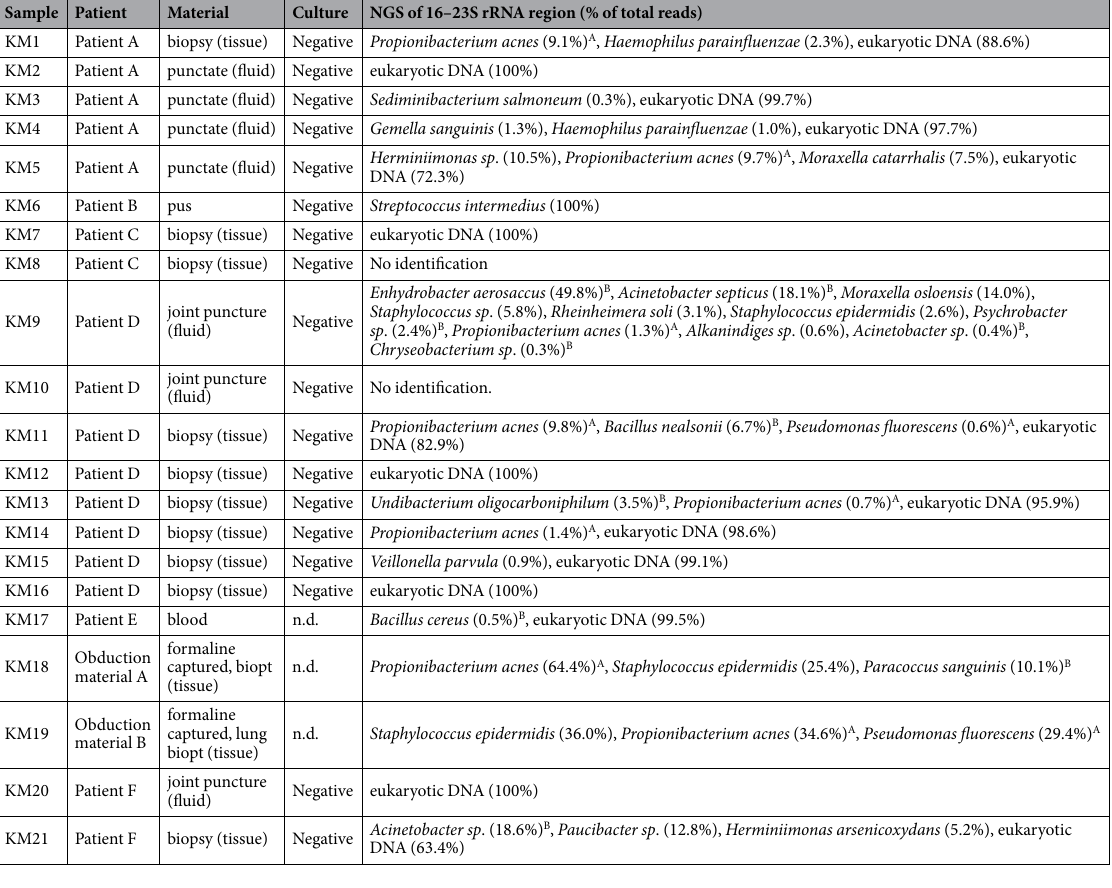
Table 3. Bacterial identification results from 21 clinical orthopedic samples based on culture and NGS of 16S- 23S rRNA region. A Species present in negative control(s) and regarded as contamination introduced during sample preparation. B Genus absent in negative controls but previously reported as contamination of DNA extraction kits, PCR and other laboratory reagents 10